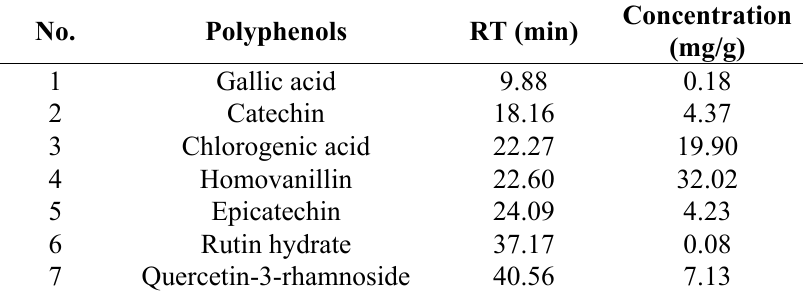
Table 1. Quantification of the identified polyphenols by RP-HPLC.